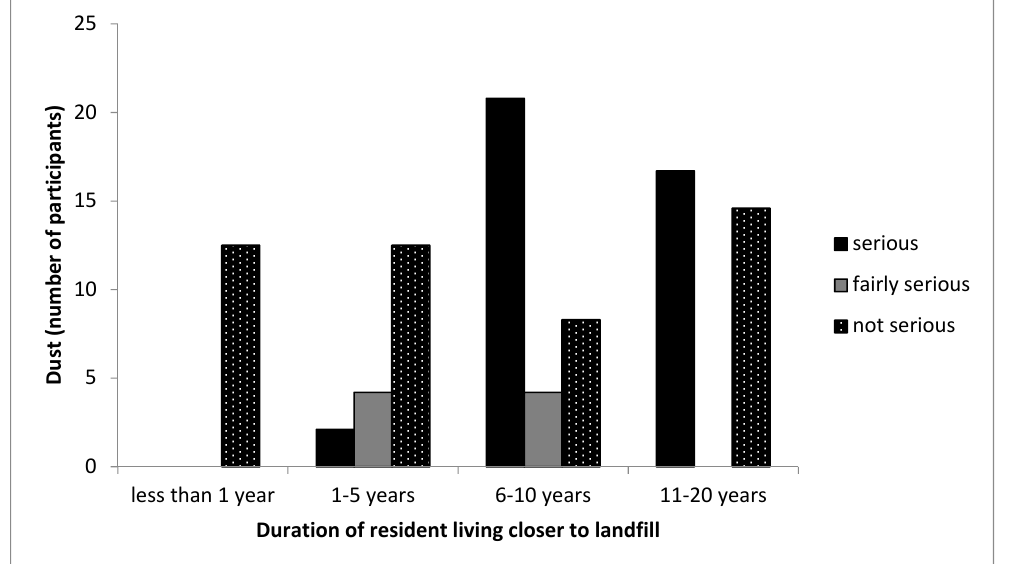
Figure 8. Cross-tabulation between the duration participants lived in the CL community and the seriousness of dust pollution. Note that the no bar section in the figure indicates there was no response by the participant.